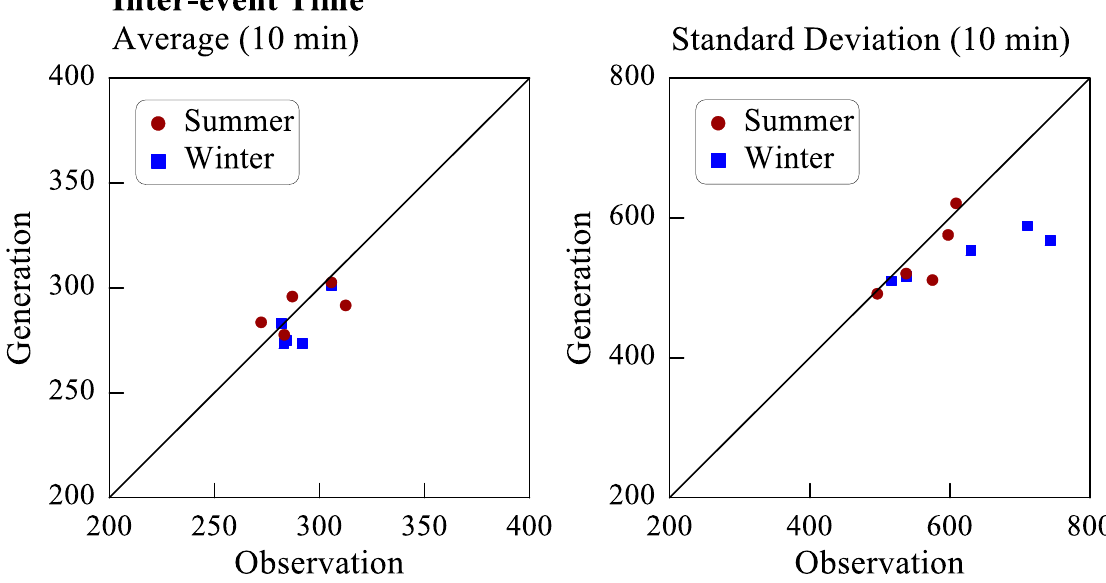
Figure 13. Comparison of the average and standard deviation values obtained for the observed and generated inter-event times.